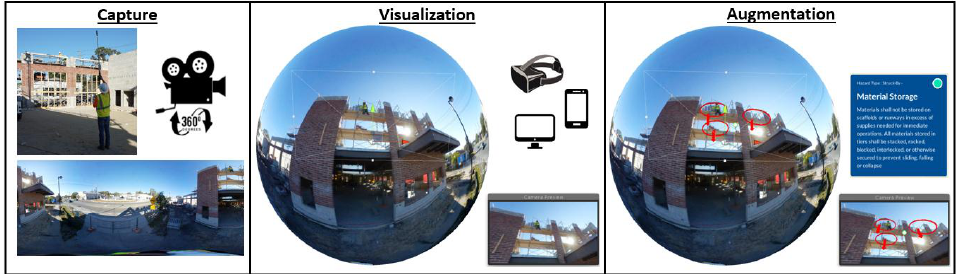
Figure 3. 360-Degree Panoramas Capture, Visualization, and Augmentation.